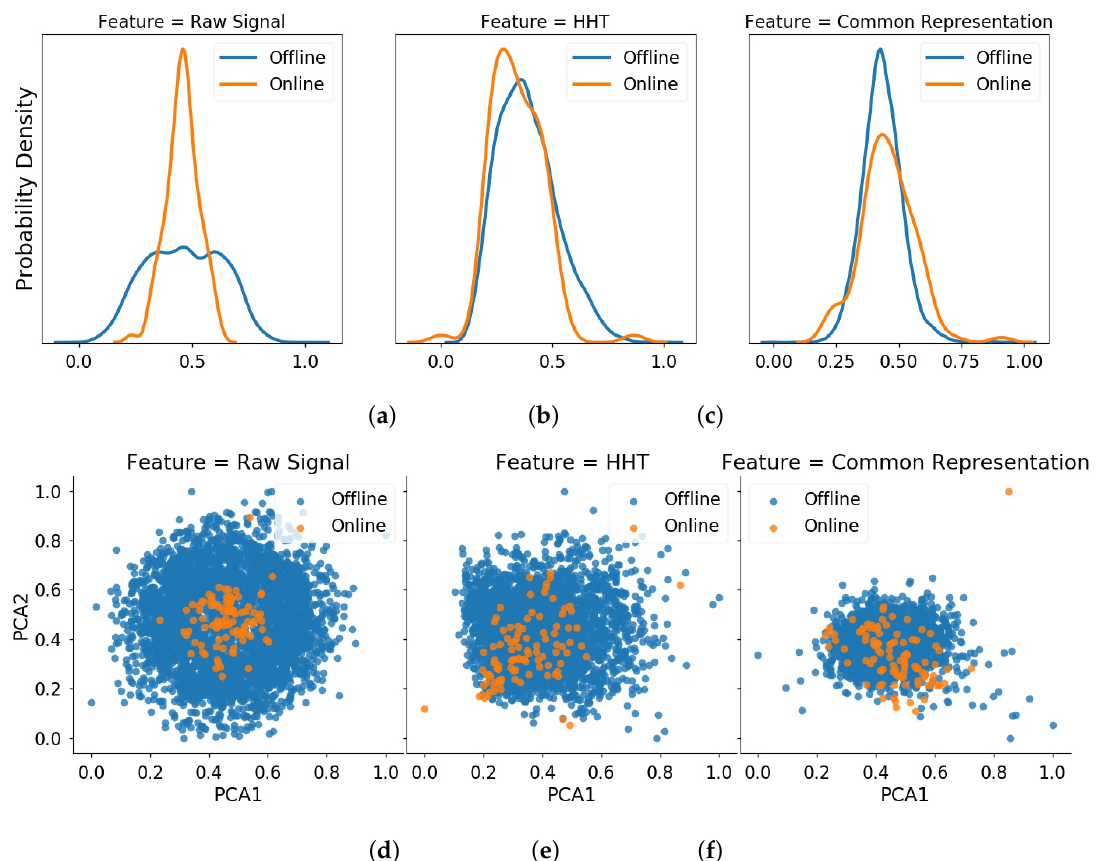
Figure 12. Comparative distribution of Target 1 and nine training bearings, with ( a – c ) the probability density distribution of raw time signal, HHT marginal spectrum, the common deep features by domain adaptation DAE, and ( d – f ) the feature distribution corresponding to ( a – c ), respectively. Please note that the legend “Online” denotes the distribution of the target bearing (Target 1) and “Offline” denotes the distribution of nine training bearings (similar to Figures 10 and